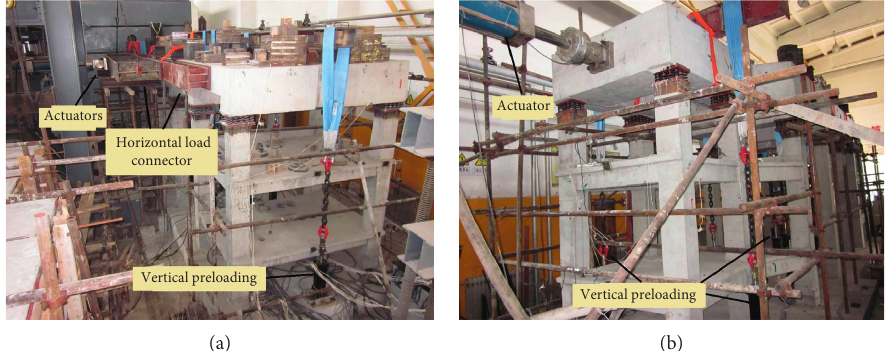
Figure 7: Photo of pseudodynamic experiment. (a) Transverse loading. (b) Longitudinal loading.